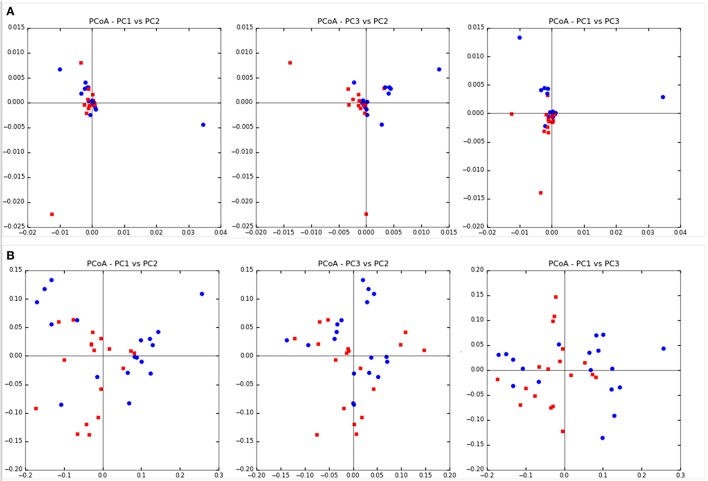
Beta diversity analysis using Unifrac analysis of dietary differences between steers fed extruded flaxseed and hay together (TMR; squares) or sequentially (Non-TMR; circles). (A) Unweighted Unifrac analysis with PC1:45.1%, PC2:21.3%, and PC3:14.76%. (B) Weighted Unifrac analysis with PC1: 24.3%, PC2:11.27%, and PC3:8.81%.